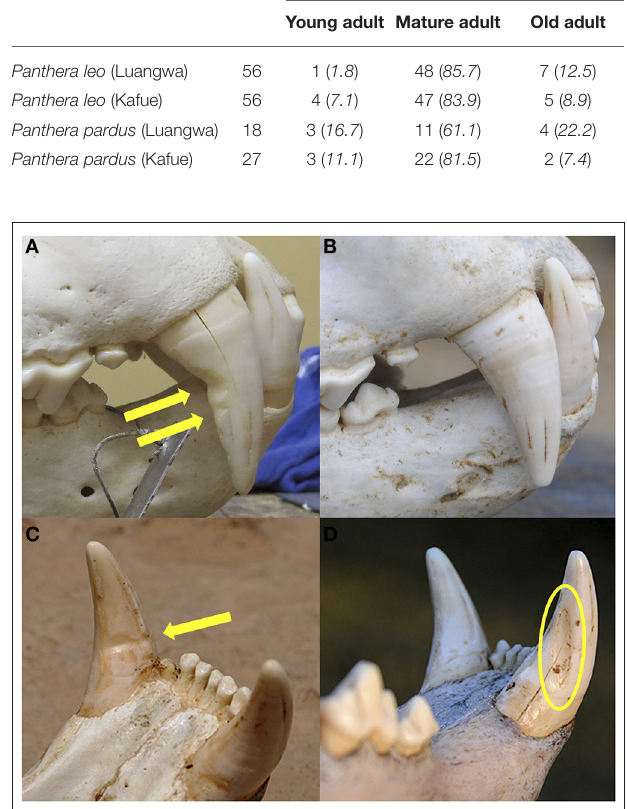
TABLE 1 | Age distribution of sampled carnivores from Luangwa Valley and Greater Kafue Ecosystem, Zambia. Sample